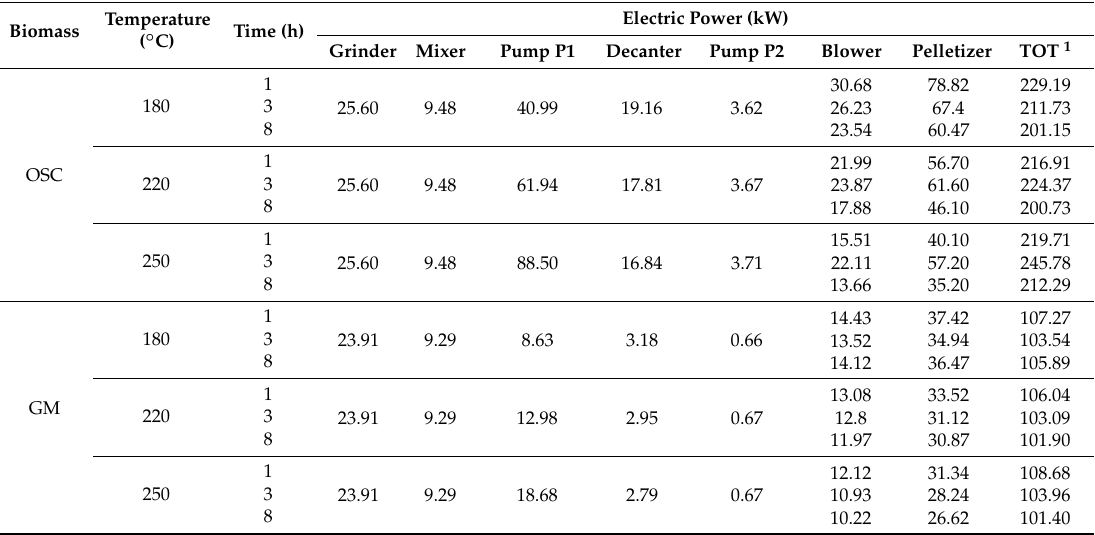
Table 2. Electric power demand at different HTC process conditions for OSC and